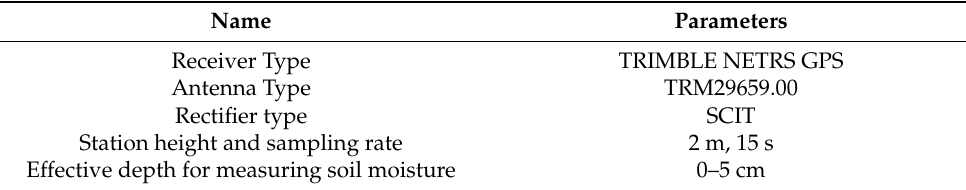
Table 1. Basic parameters of PBO measurement